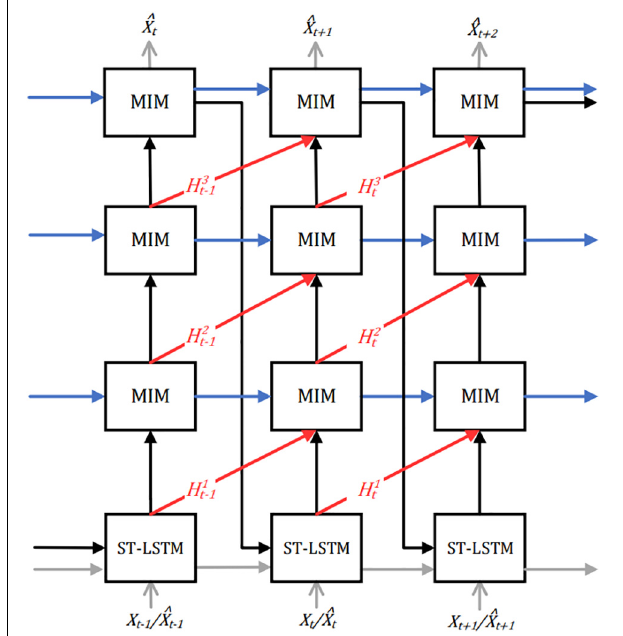
FIGURE 3 | Overall predictive model